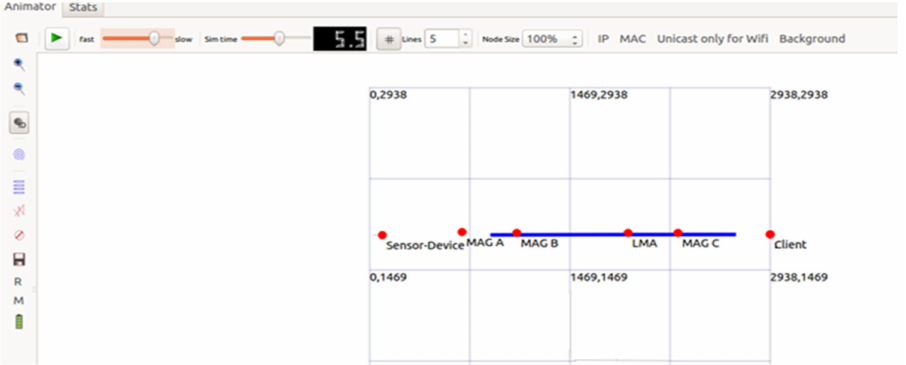
Figure 6. CoAP-PMIPv6 after handover (NetAnim